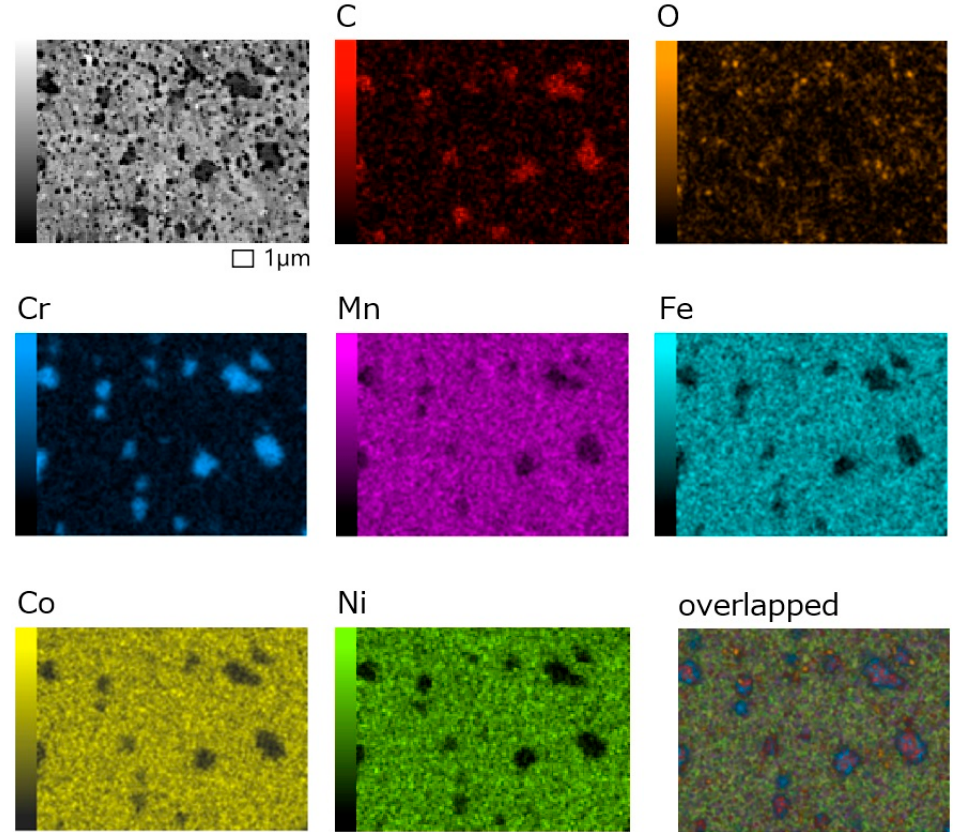
Figure 2. Elemental map of the SPS sample.